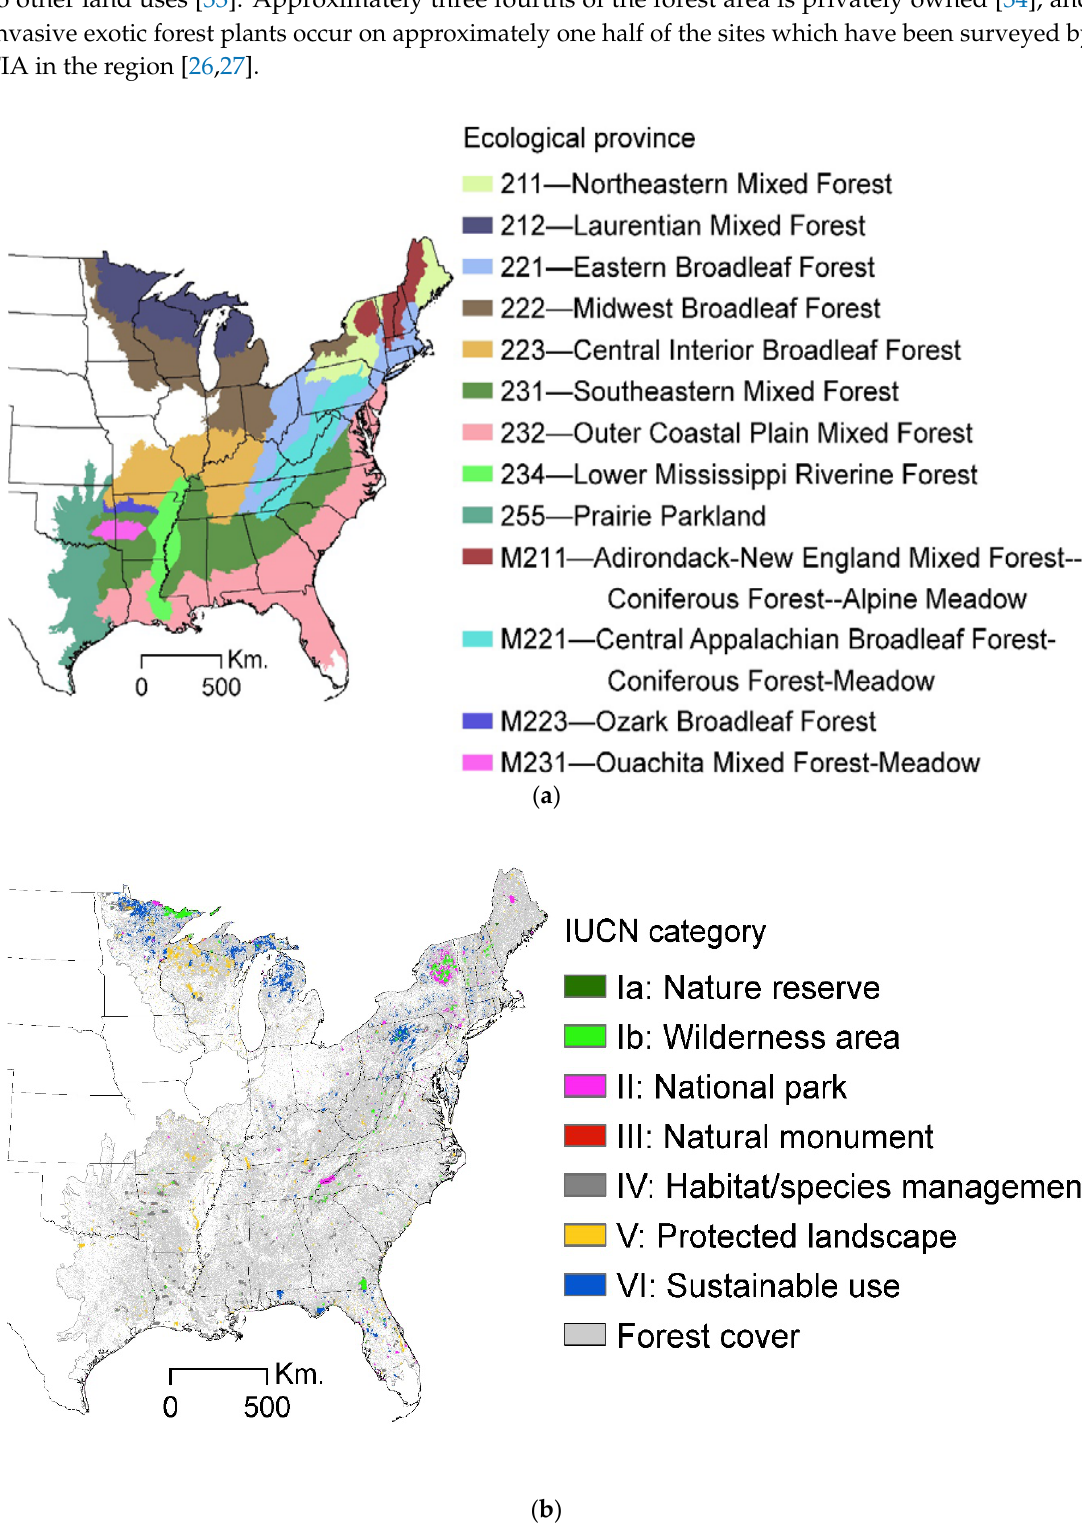
Figure 1. ( a ) Ecological provinces and study area; ( b ) IUCN protected areas and forest cover.